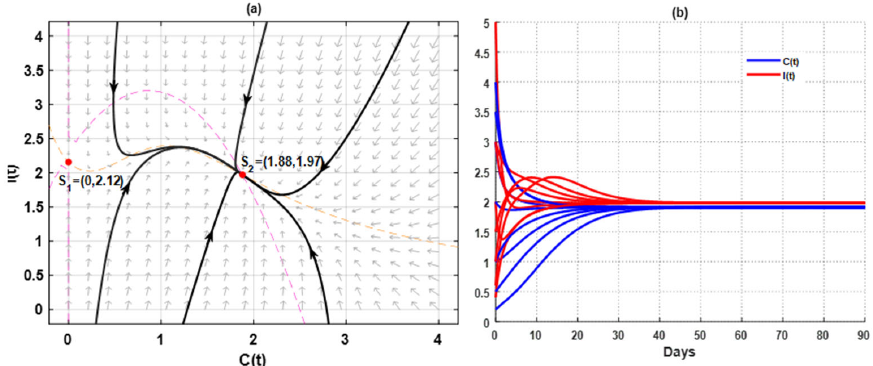
Figure 3. Numerical simulations of the CICV model for the data given in Table 1 with β 1 = 0. ( a ) Phase portrait of the CICV model. ( b ) Time series of the CICV model.